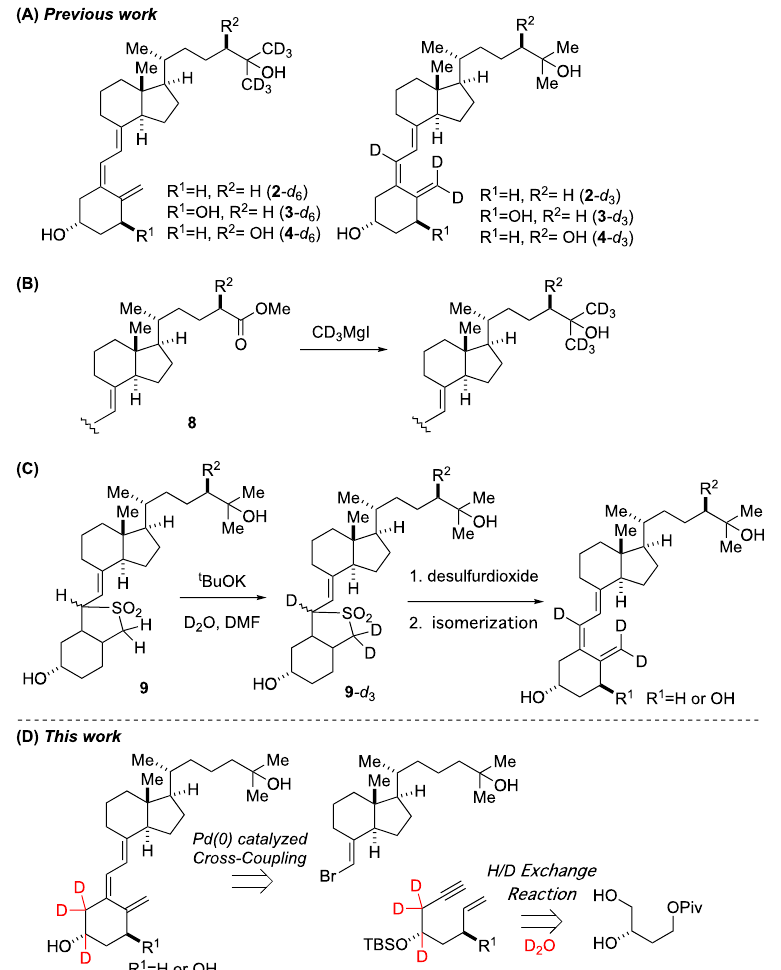
Figure 2. Synthetic strategy of deuterium-labeled D 3 metabolites. ( A ) Structures of reported deuterium-labeled D 3 metabolites. ( B ) Previous work on the synthesis of 2 − 4 - d 6 . ( C ) Previous work on the synthesis of 2 − 4 - d 3 ( D ) This work: general synthesis of deuterium-labeled D 3 metabolites.